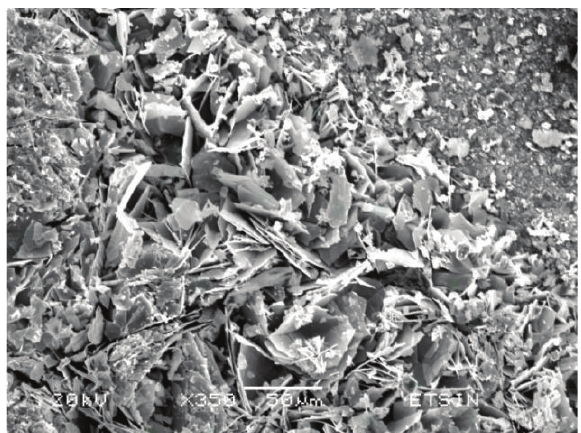
Figure 6: SEM image of the saline deposits on the polyurethane adhesive.